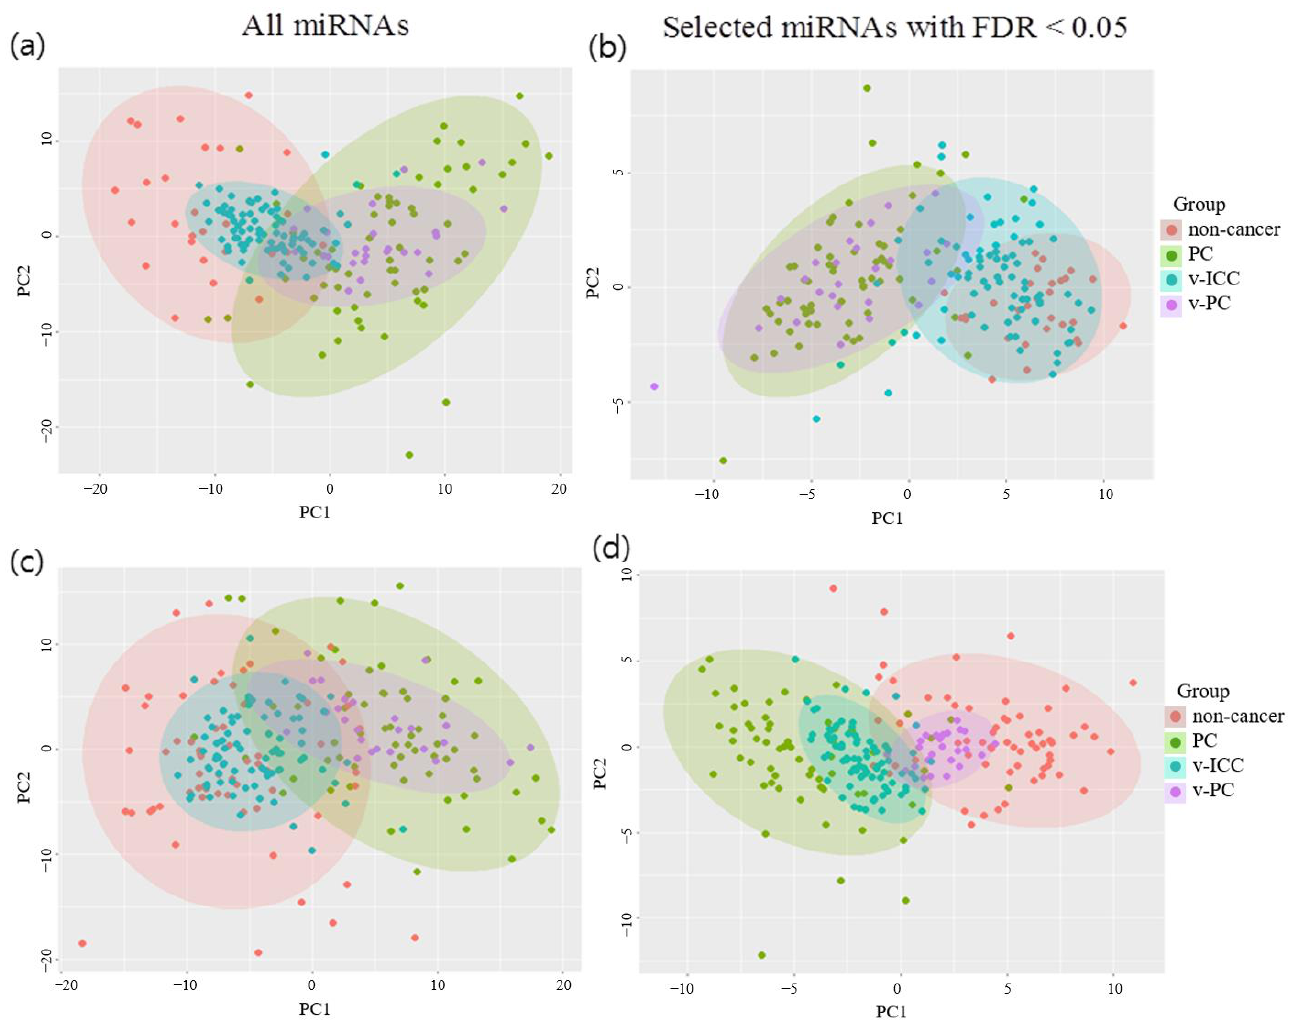
Figure 1. Principal component analysis by comparing case-control and validation samples based on different sets of miRNAs. Red, green, blue, and purple dots represent control, case, validation-control, and validation-case samples, respectively. ( a , b ) 63 pancreatic cancer (PC) cases and 29 non-cancer controls and ( c , d ) 63 PC cases and 63 non-PC controls. ( a , c ) All miRNAs and ( b , d ) selected miRNAs with false discovery rate <0.05. PC, pancreatic cancer; v-PC, validated-pancreatic cancer; FDR, false discovery rate; v-ICC, validated-intrahepatic cholangiocarcinoma.